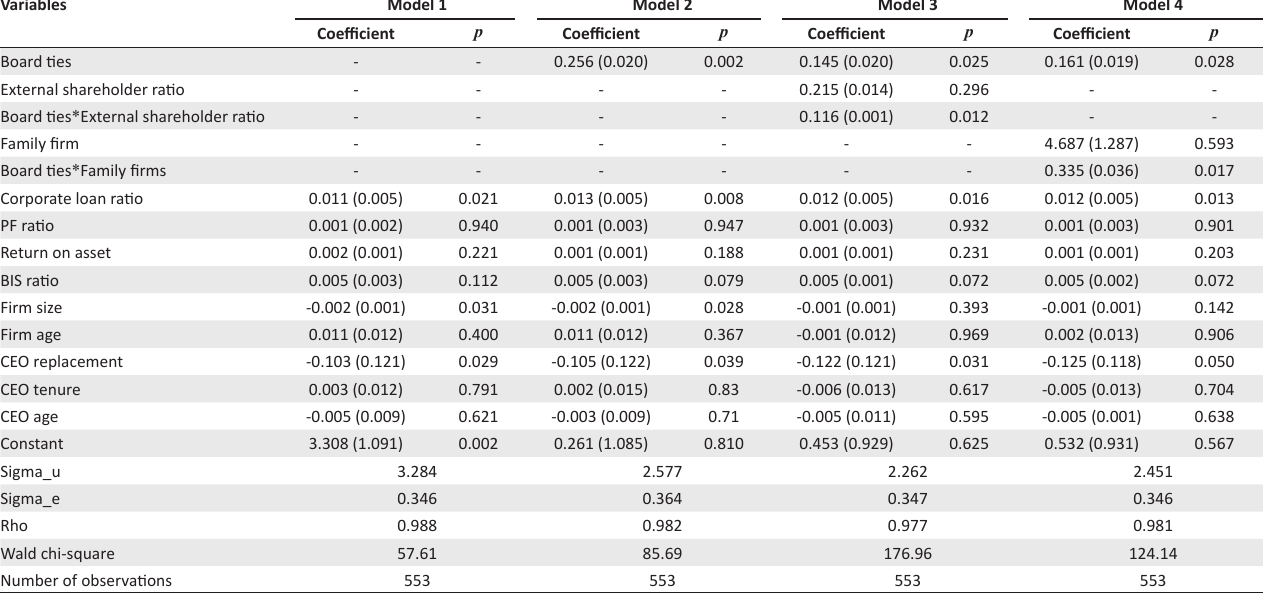
TABLE 2: Results of random-effect generalised least square regression. Variables